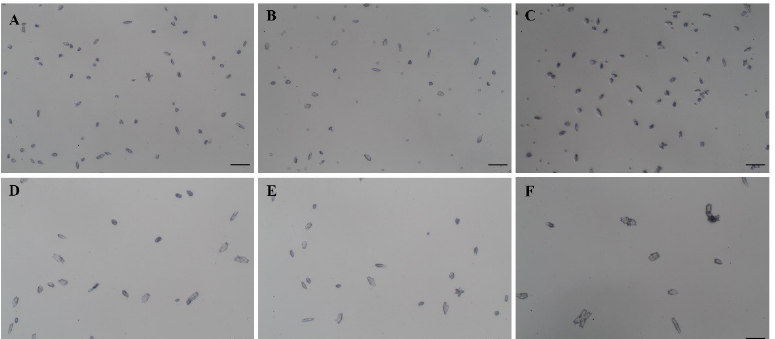
Figure 1. COM crystal growth morphology under microaerobic of the blank control ( A ), negative control ( B ), positive control ( C ), E. coli ( D ), P. mirabilis ( E ), and co-cultured E. coli and P. mirabilis ( F ). Original magnification and scale bar (—) were 100 × and 50 µ m, respectively.